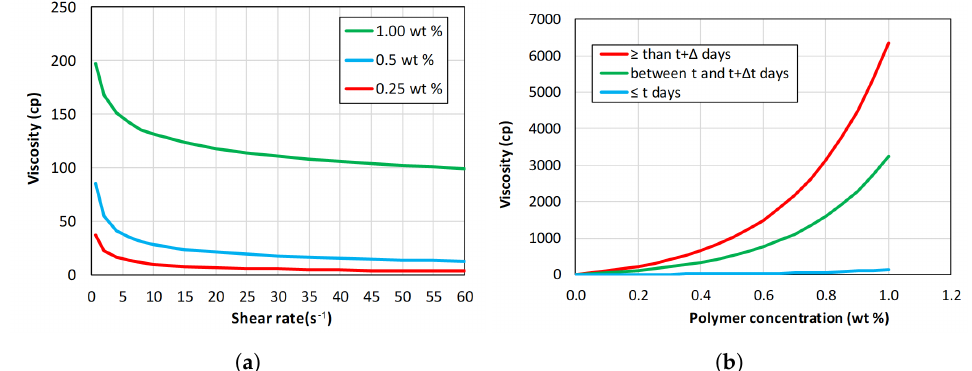
Figure 7. ( a ) Viscosity as a function of shear rate and polymer concentration for unreacted Alcomer 24 UK. ( b ) Reaction model for Alcomer 24